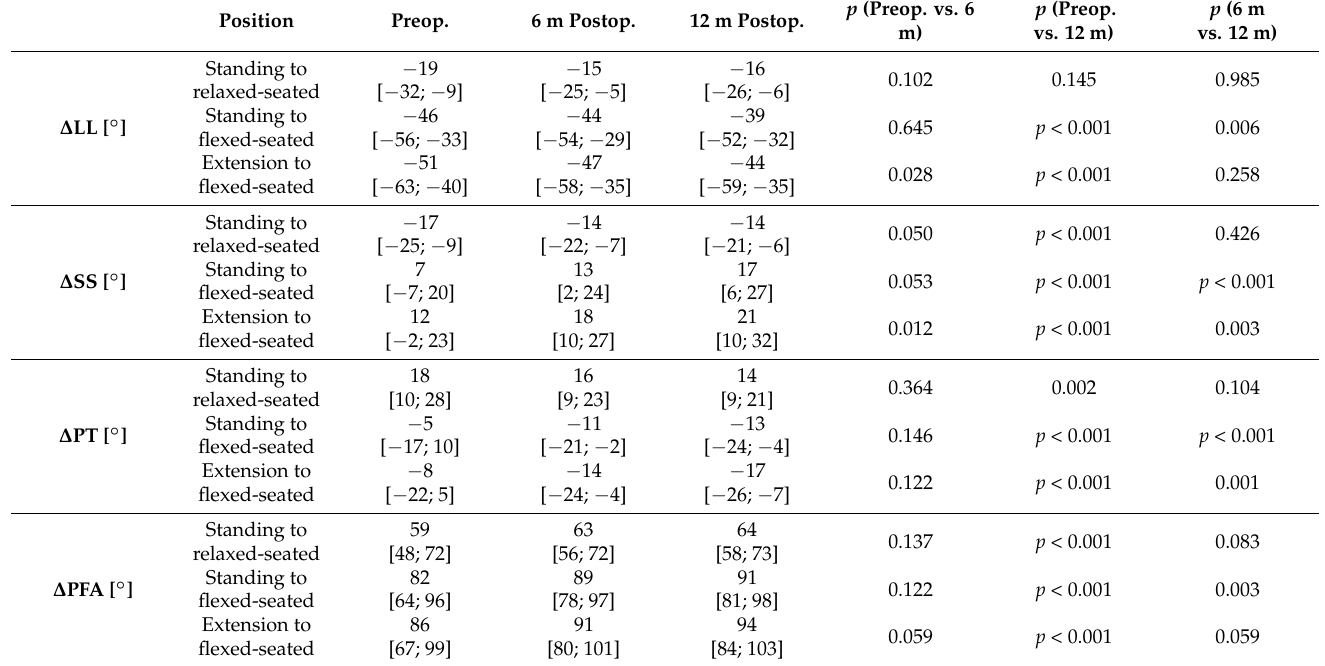
Table 3. The changes in the spinopelvic parameters of the patients between standing, extension, relaxed-seated, and flexed-seated positions preoperatively (preop.) and 6 (6 m) and 12 months (12 m) postoperatively (postop.). Values are reported as median [quartiles], and p -values are reported for significant differences between preoperatively and postoperatively. Parameters are: L1-S1 lumbar lordosis (LL), sacral slope (SS), pelvic tilt (PT), and pelvic-femur angle